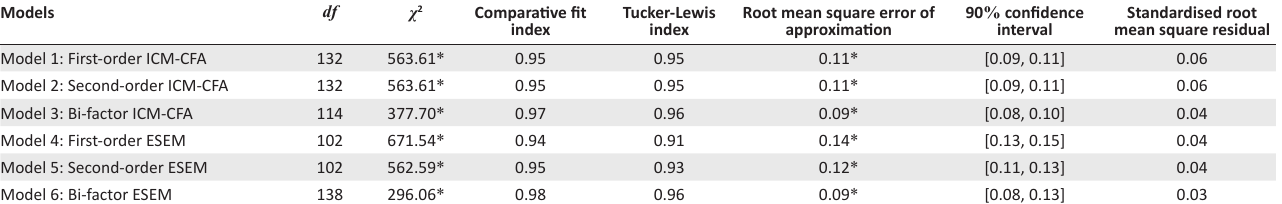
TABLE 1: Fit statistics for the measurement models.